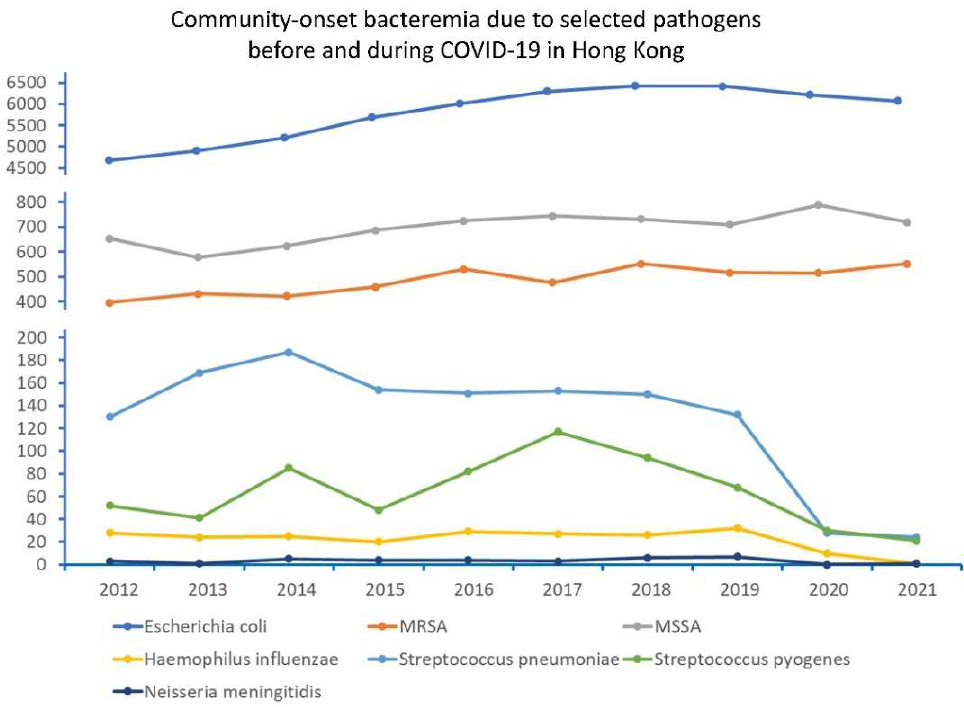
Figure 4. Community-onset bacteremia due to selected pathogens before and during COVID-19 in Hong Kong. Note: the selected microorganisms included pathogens with potential respiratory transmission ( Streptococcus pyogenes, Streptococcus pneumoniae, Haemophilus influenzae, and Neisseria meningitidis ), and pathogens commonly identified in the blood culture including methicillin-sensitive Staphylococcus aureus (MSSA), methicillin-resistant S. aureus (MRSA), and Escherichia coli , were used as controls. Statistical analysis is shown in Table 1.